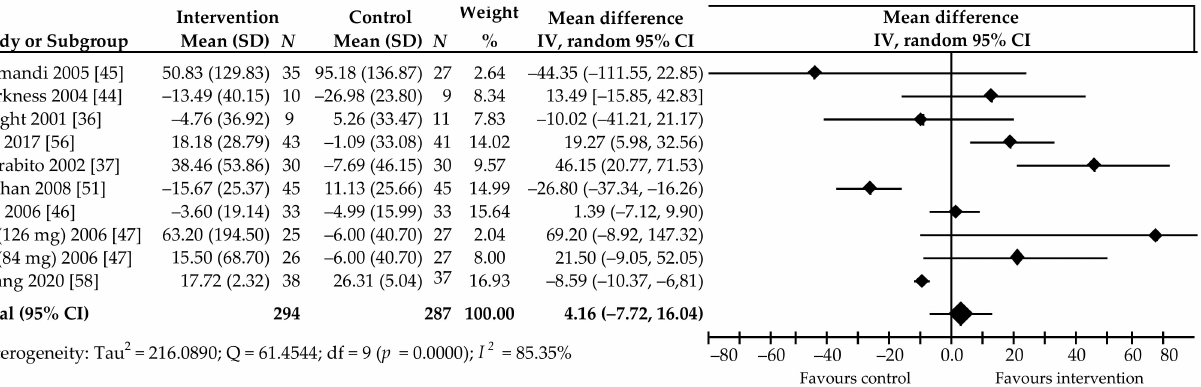
Figure 4. Percentage change in serum Osteocalcin values associated with intake of soy isoflavones, compared with placebo. Note: numbers following authors’ name indicate Isof dose in studies with more than one treatment arm; data calculated from the random-effects model are presented as weighted mean difference; IV, inverse variance; df, degrees of freedom; the horizontal lines denote the 95% CIs, some of which extend beyond the limits of the